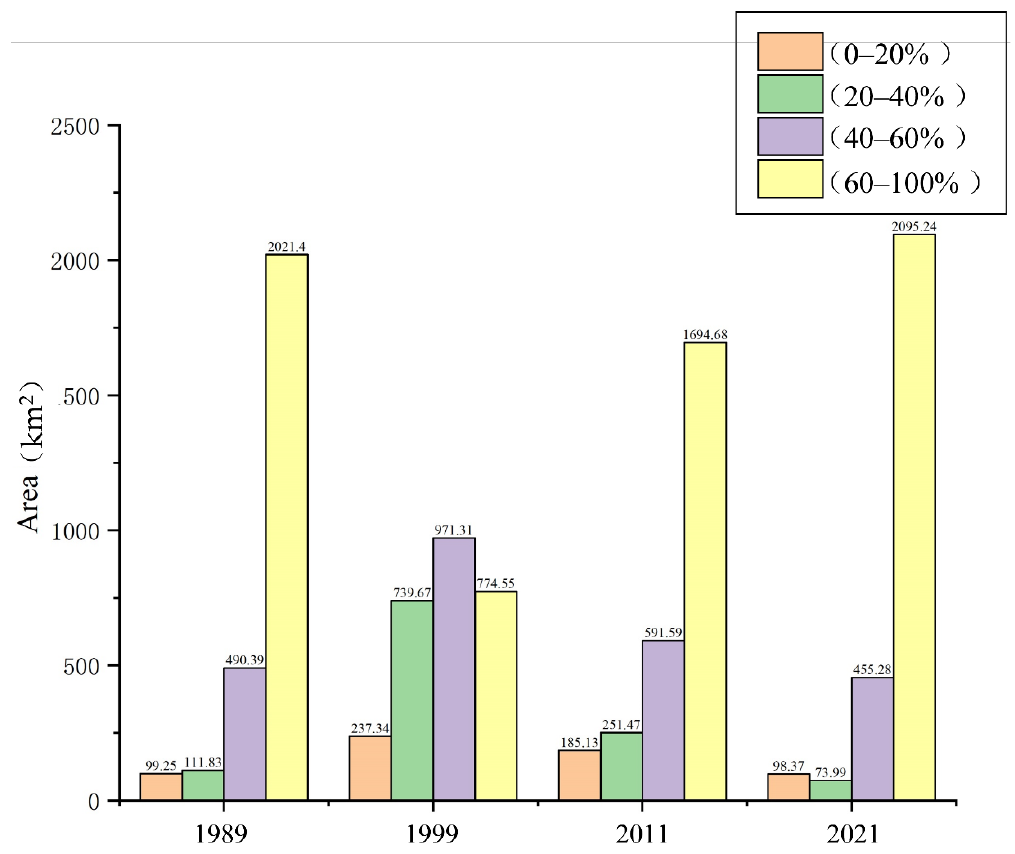
Figure 8. Areas of different vegetation coverage classification intervals in 1989, 1999, 2011, and 2021.